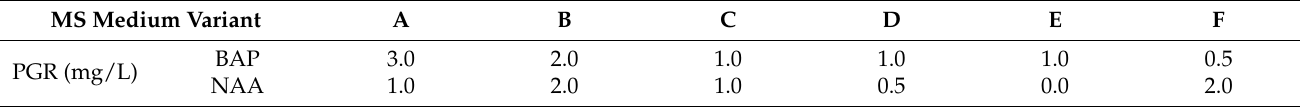
Table 7. PGR composition of the Murashige and Skoog medium variants applied in the experiment with Scutellaria brevibracteata subsp. subvelutina in vitro